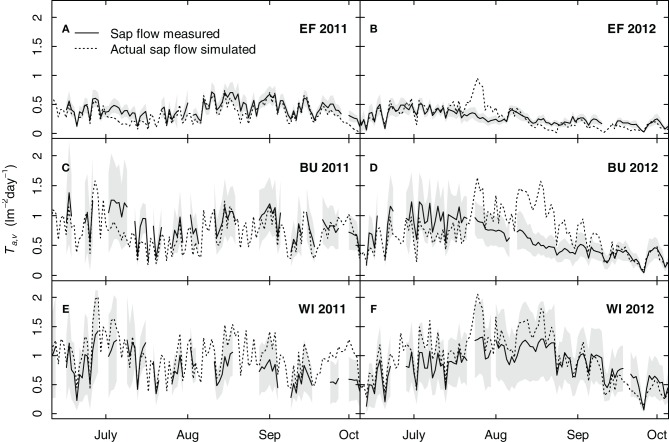
Simulated and measured seasonal courses of grapevine transpiration for three vineyards (EF, BU, WI) and 2 years [2011 (A, C, E), 2012 (B, D, F)]. Solid lines show measured transpiration rates by sap flow (means of 6 vines per vineyard), the shaded area shows the confidence interval (p < 0.05) and dotted lines show the simulated transpiration rates (calculated with an uniform grapevine transpiration coefficient).